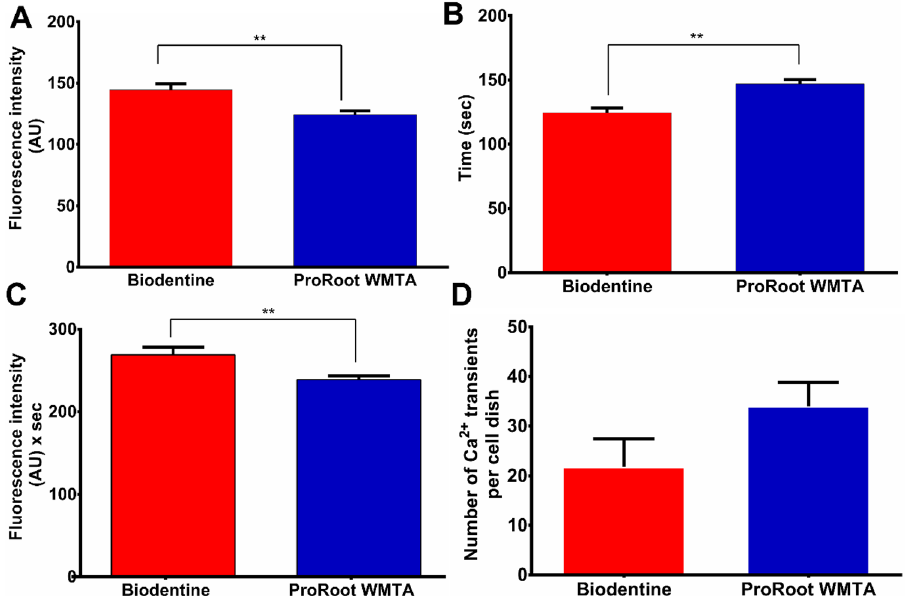
Figure 3. Properties of cellular Ca 2+ dynamics in response to biomaterial exposure. ( A ) Peak amplitude of Ca 2+ changes. Unpaired t test with Welch’s correction shows significantly higher peak amplitude in the Biodentine group ( p < 0.0001). ( B ) Time to maximum amplitude of the Ca 2+ change. Unpaired t test with Welch’s correction shows significantly increased time to max amplitude in the ProRoot WMTA group ( p < 0.0001). ( C ) Area under the curve of the Ca 2+ changes. Unpaired t test with Welch’s correction shows significantly higher area under the curve in the Biodentine group ( p < 0.01). ( D ) Number of Ca 2+ transients per cell